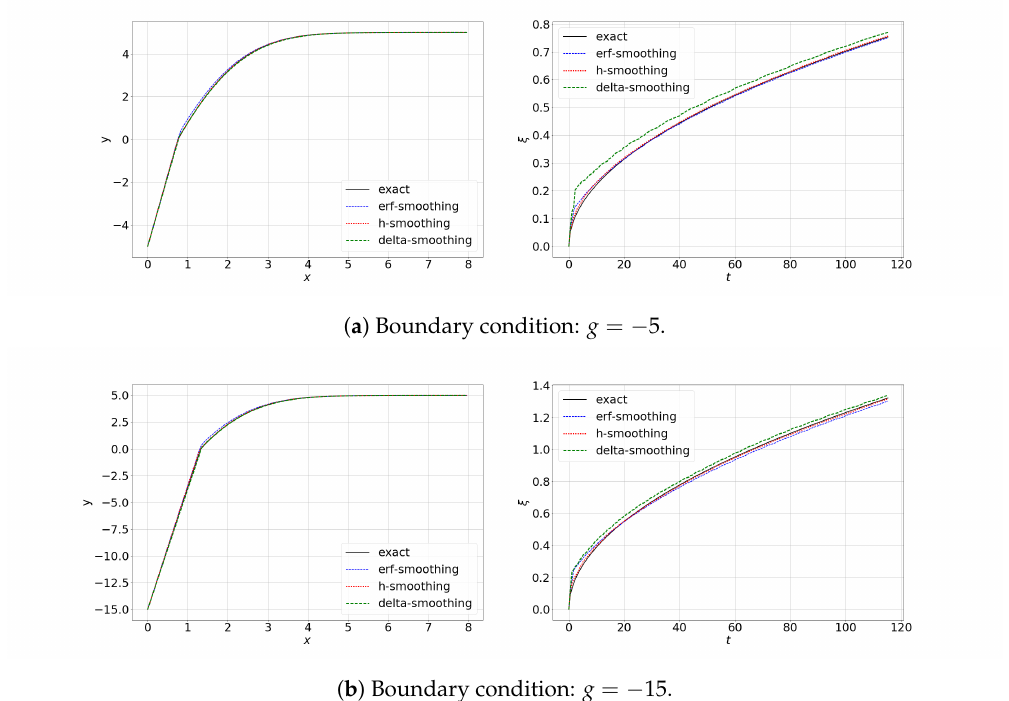
Figure 2. One-dimensional problem. Exact solution (black color). Numerical solutions using error function (erf) smoothing (blue color), smoothing in one spatial interval (red color), and linear smoothing in the ∆ interval (green color). Left: solution at the final time. Right: phase change interface